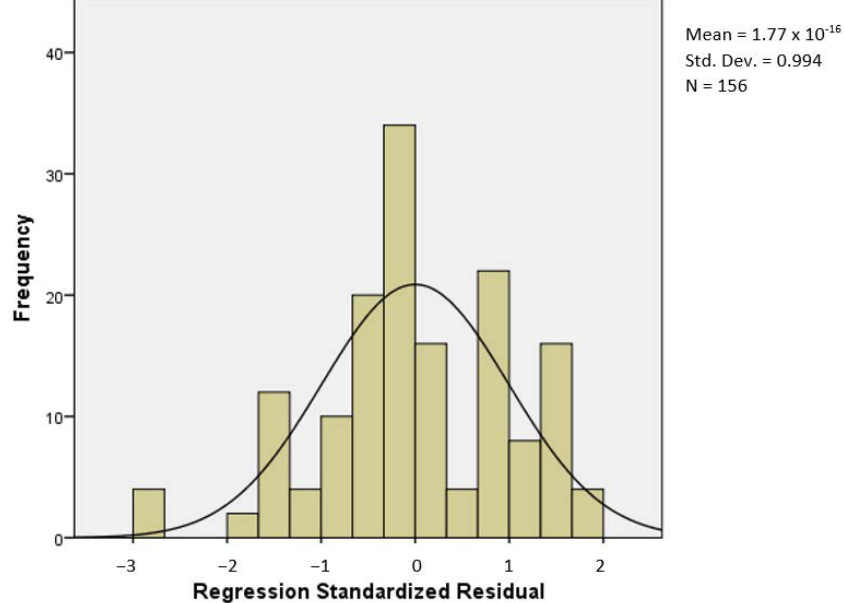
Figure A3. Histogram using mental health as the dependent variable.